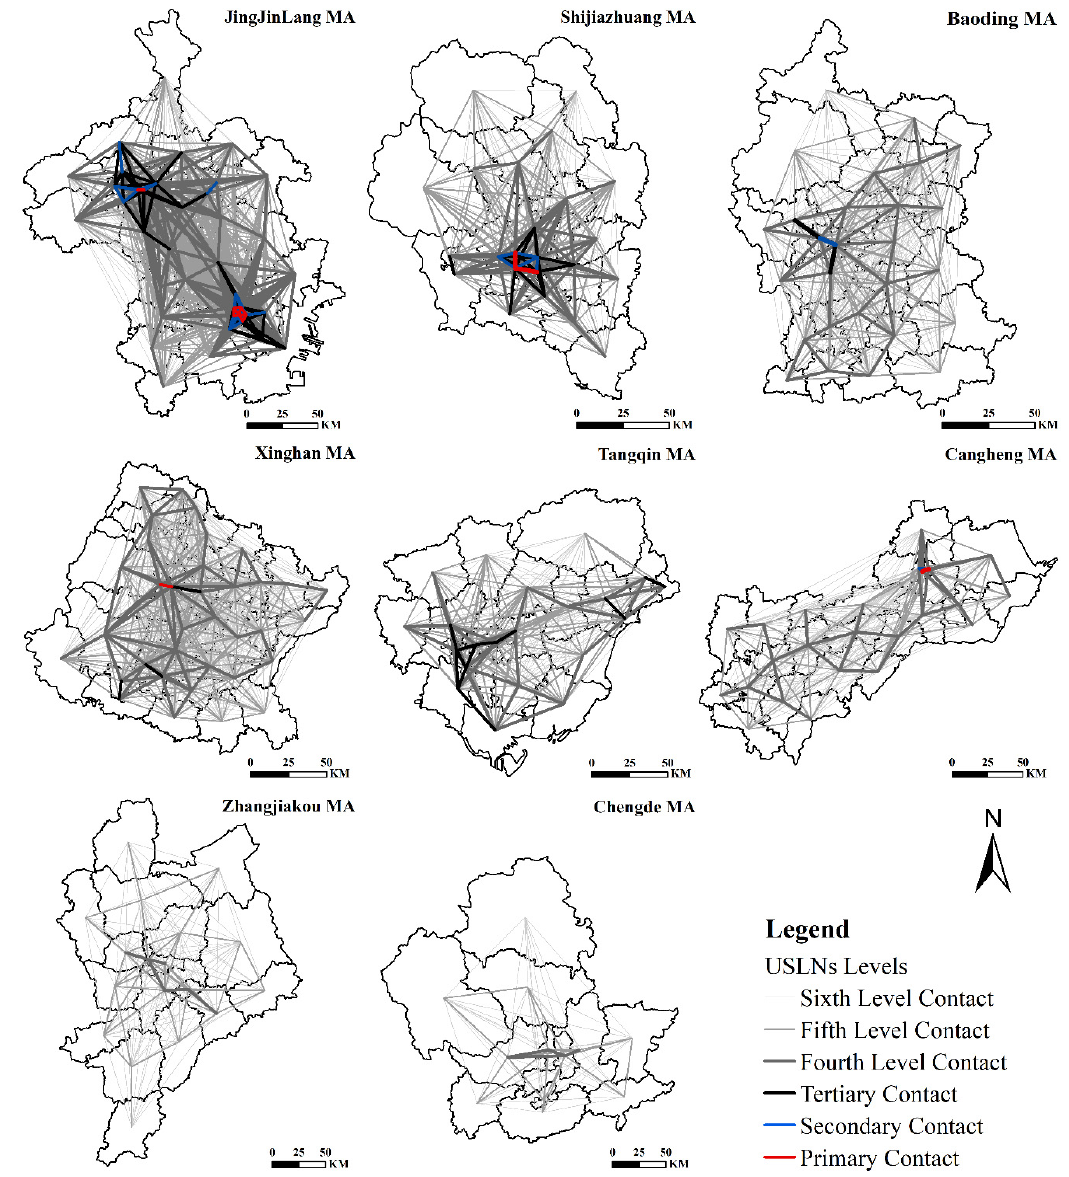
Figure 9. Linkages within the metropolitan areas.